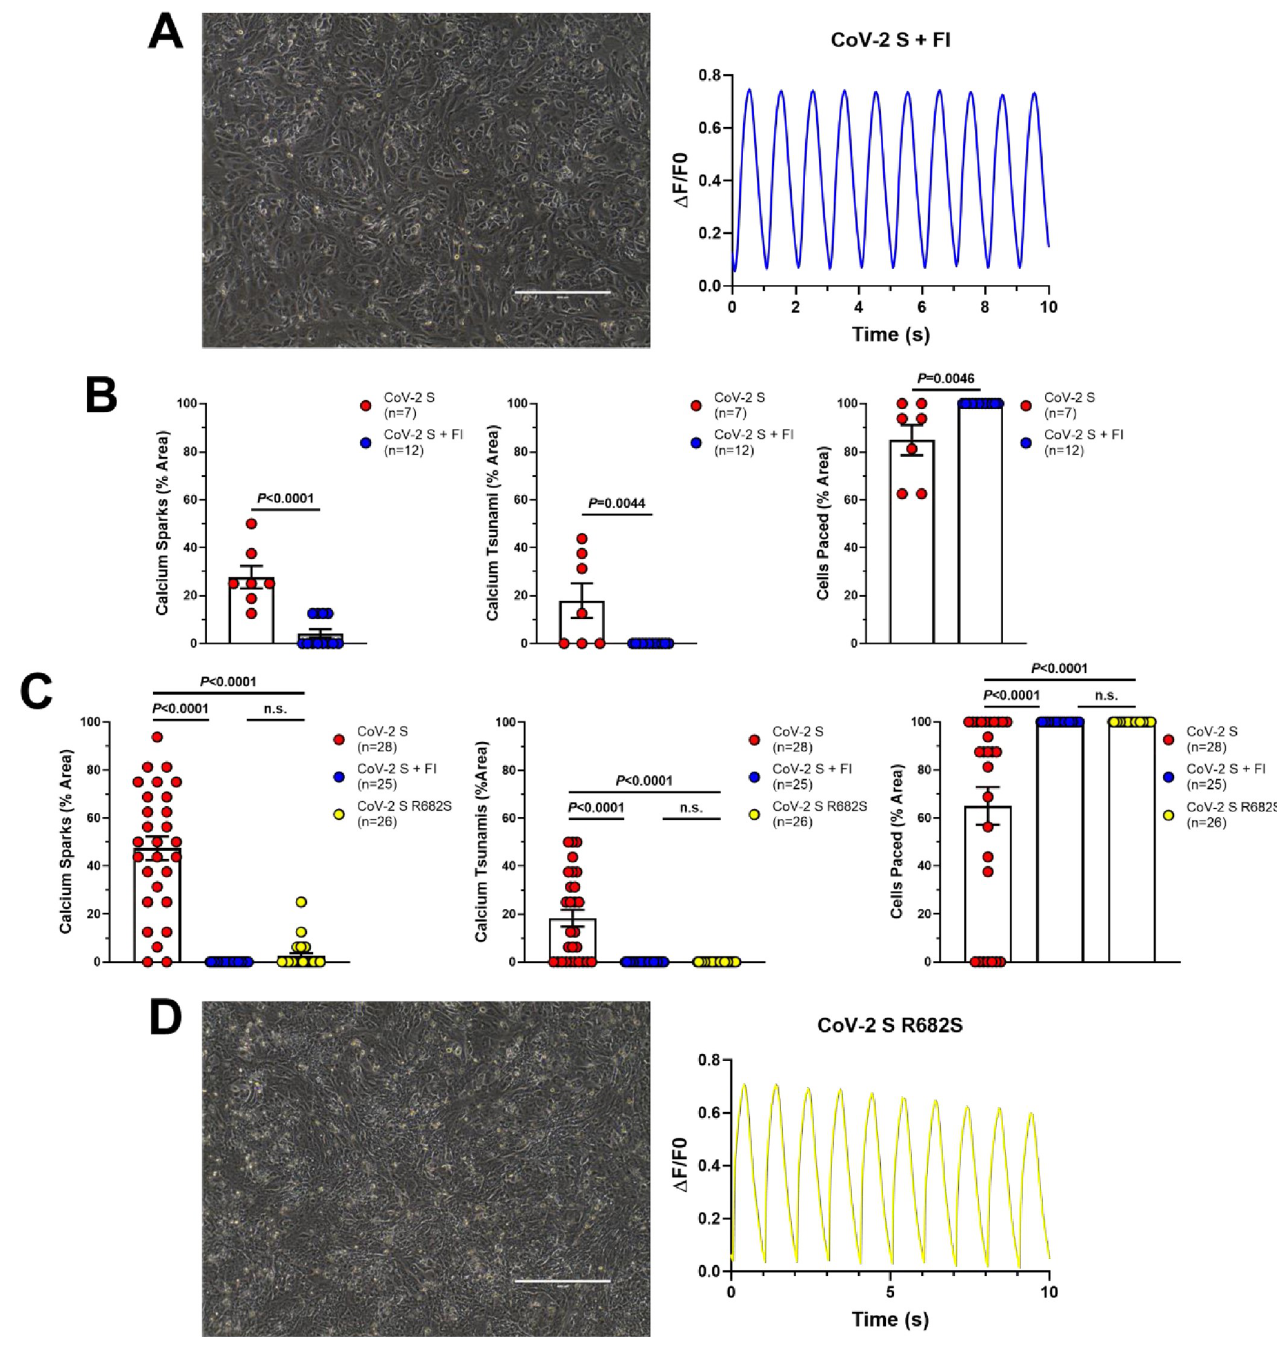
Fig 5. Biochemical and genetic interference prevents formation of hiPSC-CM syncytia and restores calcium handling. ( A ) Light microscopy (left) and representative Fluo-4 calcium imaging trace (right) from CoV-2 S-transfected hiPSC-CMs treated with furin inhibitor (FI). Scale bar 400 μ m. ( B ) Quantification of calcium sparks (left), calcium tsunamis (middle), and pacing (right) in CoV-2 S-transfected (n = 7) and CoV-2 S + FI (n = 12) hiPSC-CMs. ( C ) Quantification of calcium sparks (left), calcium tsunamis (middle), and pacing (right) in a second line of hiPSC-CMs transfected with CoV-2 S (n = 28), CoV-2 S + FI (n = 25), and CoV-2 S R682S (n = 26). ( D ) Light microscopy (left) and representative Fluo-4 calcium imaging trace (right) from CoV-2 S R682S- transfected hiPSC-CMs. Scale bar 400 μ m. Graphs are presented as mean ± SEM. Unpaired two-tailed Student’s t-tests were conducted to determine significance between two groups and one-way ANOVAs with Tukey’s multiple comparisons tests were conducted to determine significance between three groups.